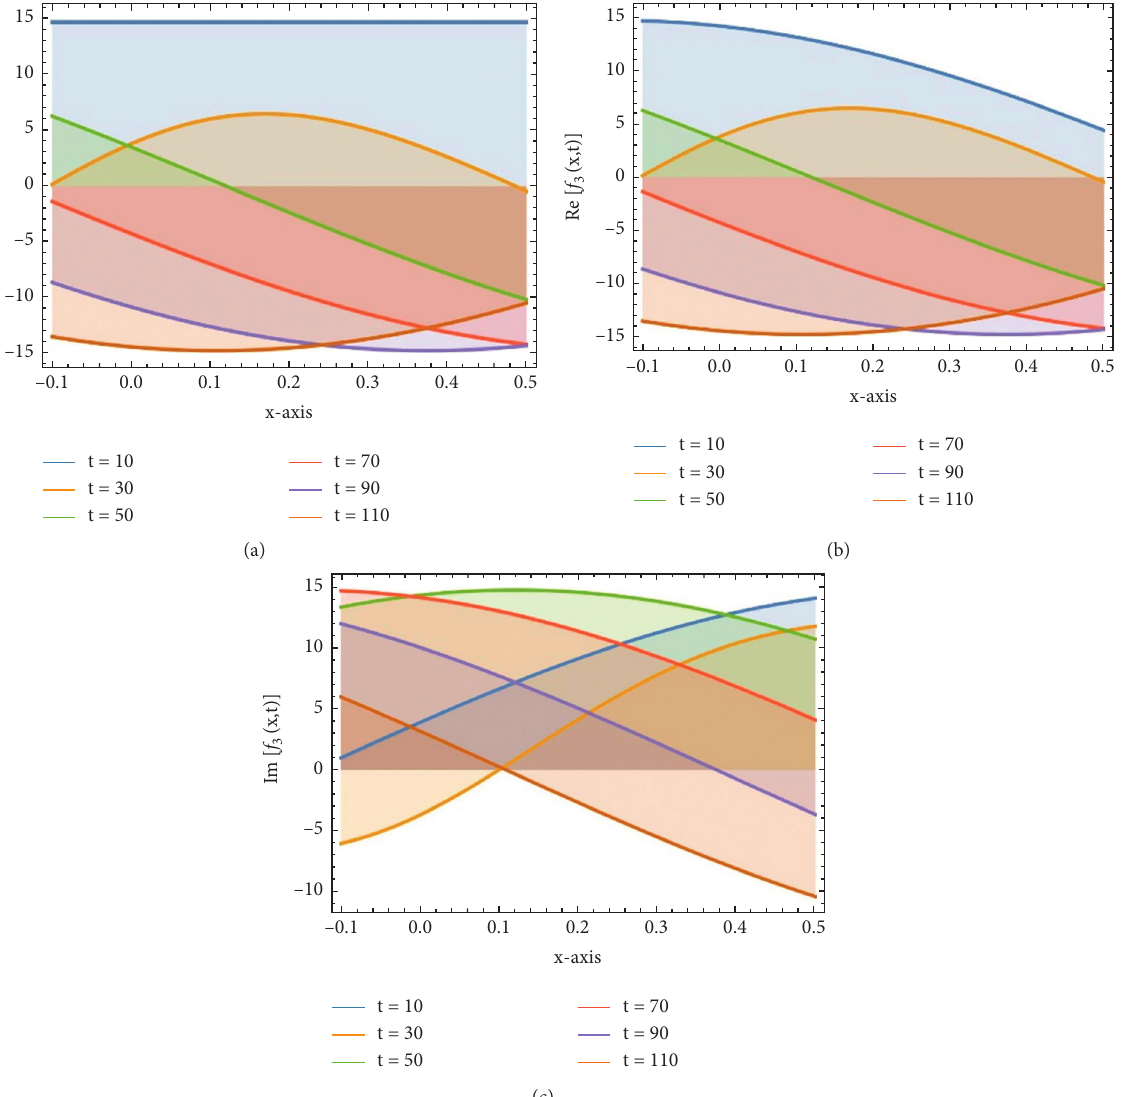
Figure 6: Optical soliton wave solutions of the absolute, real, and imaginary value of equation (26) in two-dimensional view when ( c � − 1, c � − 4, and h � ϑ � 0 . 5, c 2 3